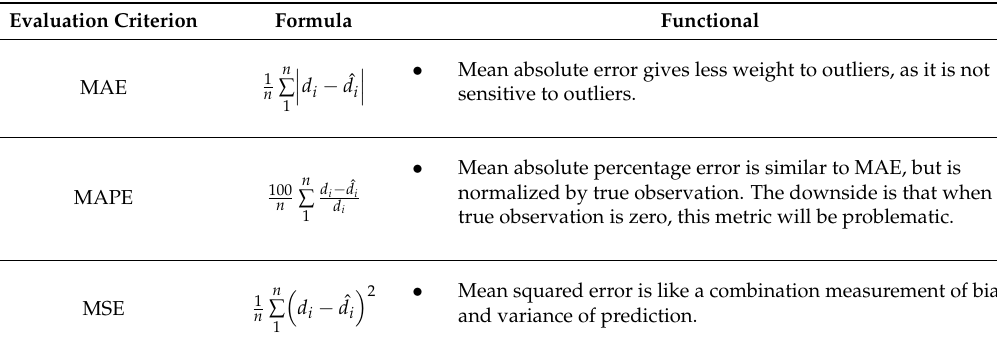
Table 6. Formulas of MAE, MAPE, and MSE evaluation criteria.